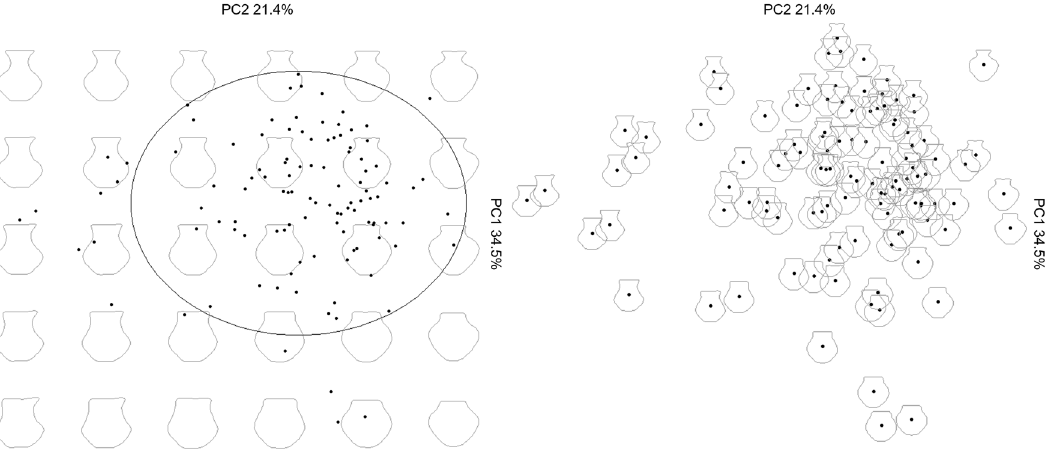
Figure 10: Left: PCA of all samples, overlaid with morphospace and 95% con fi dence ellipsis. Right: PCA of all samples, with overlaid morphology for each sample individually, utilizing the ‘ plot_PCA ’ function.